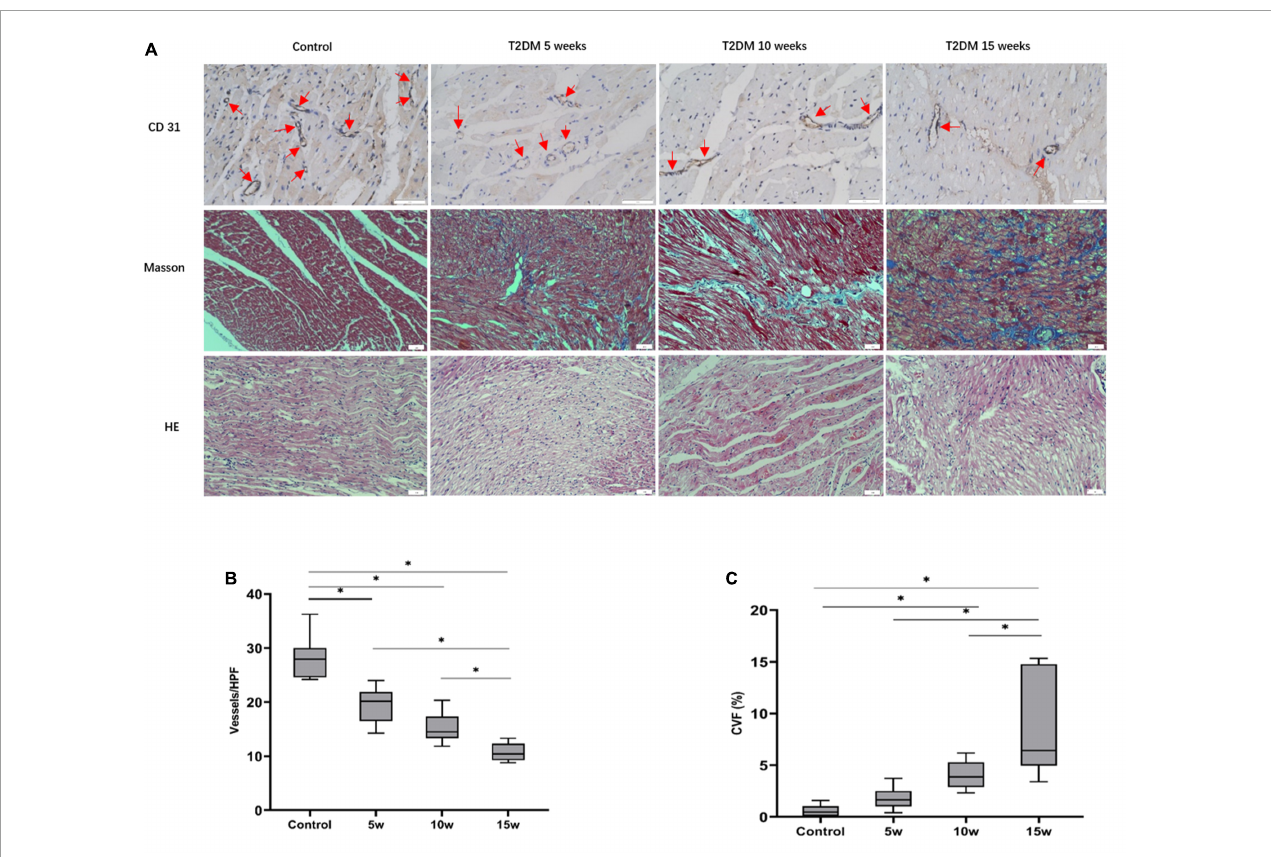
FIGURE4 Histopathologic analysis of myocardial alterations in the interventricular septum. (A) CD31 staining (scale bars = 50 µ m): With increasing durations of T2DM, the number of micro-vessels gradually declined (red arrows). Masson staining (blue, fibrosis, red, myocardial fibers; scale bars = 50 µ m); with increasing durations of T2DM, increase in interstitial fibrosis are seen. Histological changes of heart tissue (scale bar = 50 µ m). A quantitative analysis of the (B) microvascular density (MVD) and the (C) collagen volume fraction (CVF) of six random fields at × 200 magnification. The data are expressed as the means ± SD. HPF, high power field; T2DM, type 2 diabetes